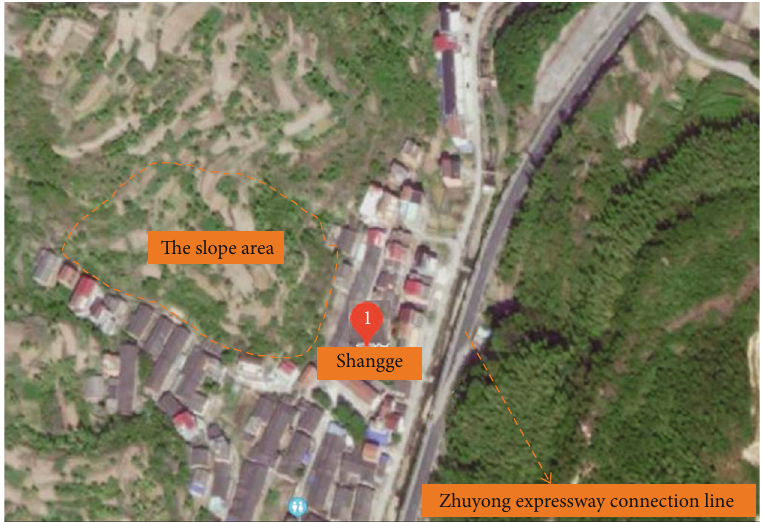
Figure 1: The geographical location of the slope of the Shangge Village.